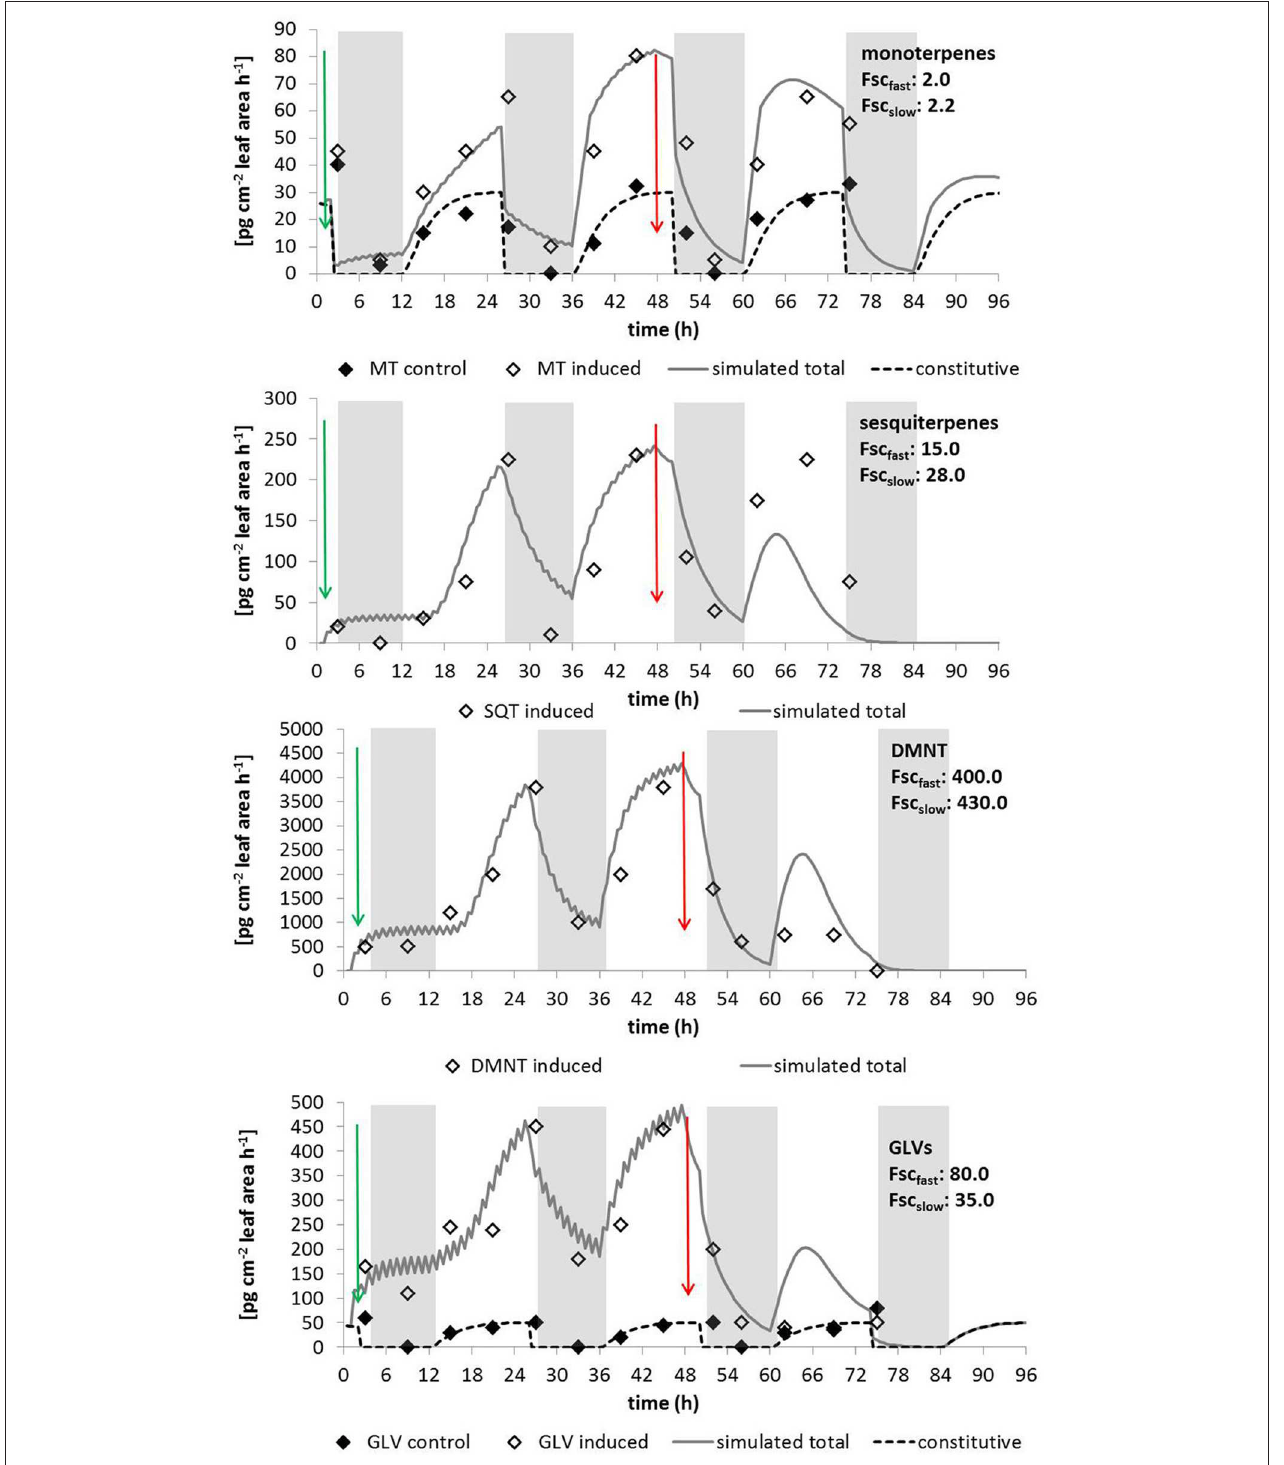
FIGURE 4 | Simulated and measured emissions of (from the top to the bottom) α -pinene, β -caryophyllene, DMNT, and the GLV hexenyl acetate which are typical representatives for the indicated emission types. Data are taken from McCormick et al. (2014a) measured at young poplar trees ( Populus nigra ) exposed to gypsy moth larvae ( Lymantria dispar ). Shaded areas denote dark periods without de-novo biosynthesis; green arrows show the start of the exposure to larvae and red arrows the end of larvae feeding. Indicated scaling parameters are given for 1-h induction cycles; for other parameters see text and Table 1 .